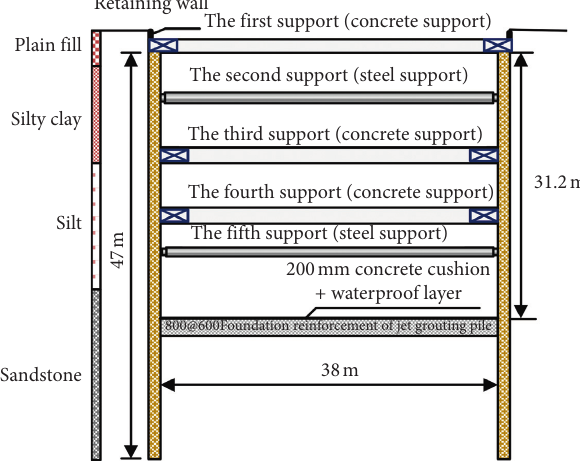
Figure 2: Design drawing of AA section. Table 1: Construction